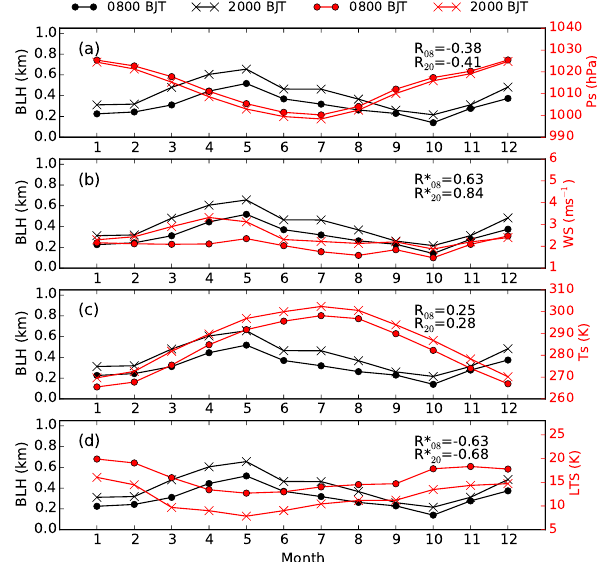
Figure 12. Climatological mean annual cycle of CMA-BLH at the Beijing site (39.8 ◦ N, 116.47 ◦ E) at 08:00BJT (dot symbols) and 20:00BJT (x symbols), respectively, superimposed by the counter- parts of meteorological parameters, including (a) surface pressure ( P s ), (b) 10m wind speed (WS), (c) near-surface temperature ( T s ) and (d) lower tropospheric stability (LTS). The correlation coeffi- cients at 08:00 ( R 08 ) and 20:00BJT ( R 20 ) between CMA-BLH and meteorological parameters are given in each panel as well, and the star superscripts indicate the values that are statistically significant ( p <